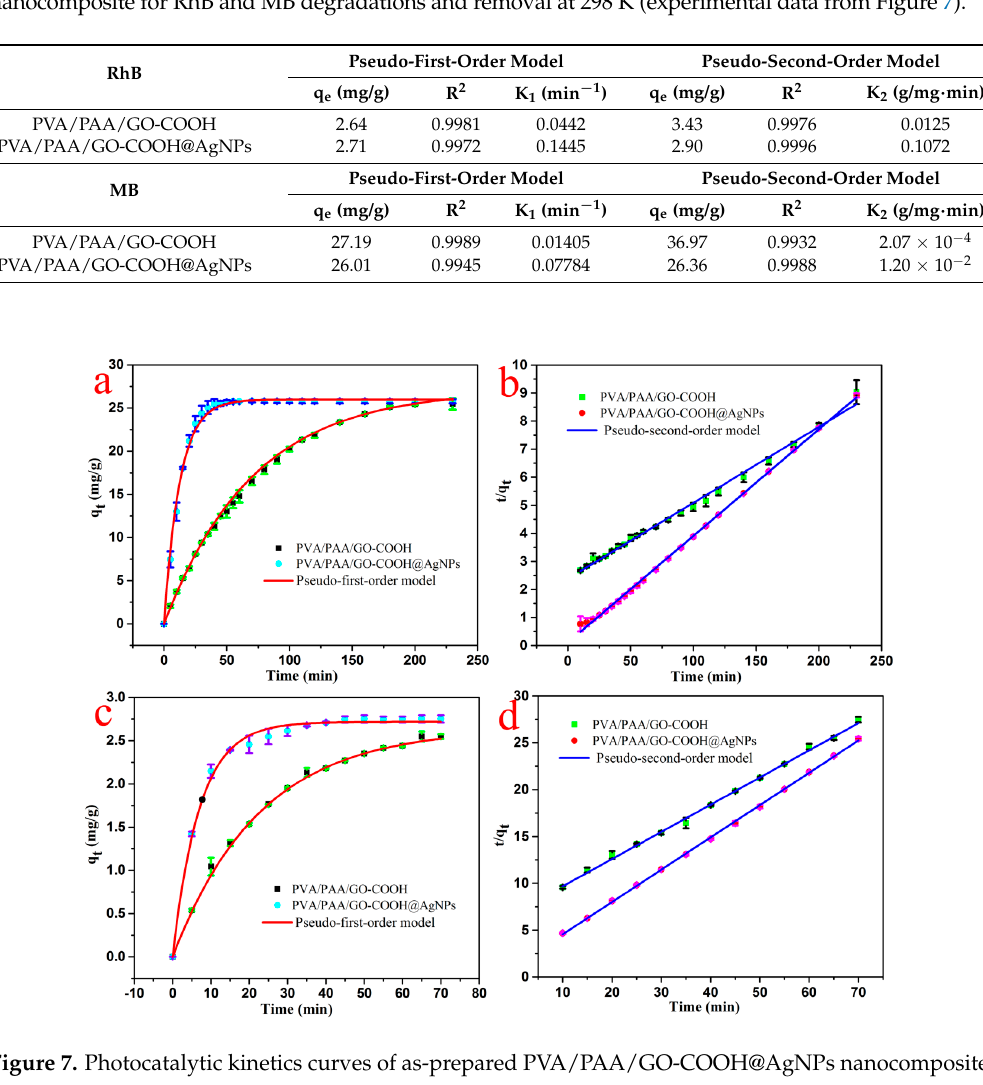
Figure 7. Photocatalytic kinetics curves of as-prepared PVA/PAA/GO-COOH@AgNPs nanocomposite on MB ( a , b ) and RhB ( c , d ) at 298 K.